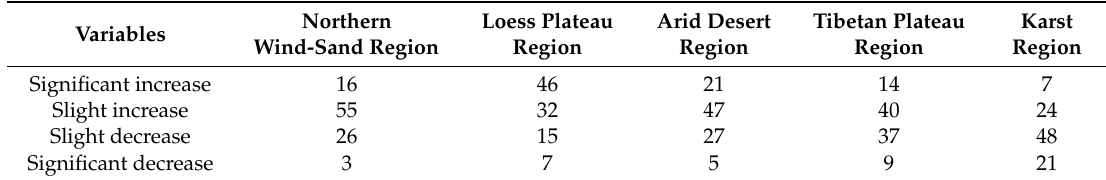
Figure 2. Spatial pattern of the actual NPP (NPP a ) change trends and significance level ( p < 0.05) in the Northern Wind-sand region ( a ), Loess Plateau region ( b ), Arid Desert region ( c ), Tibetan Plateau region ( d ), and Karst region ( e ) from 2000 to 2015. The blank area in the figure is an area of no vegetation, such as a desert, urban area, etc. Table 2. Spatial change statistics of the NPP a in the five ecologically vulnerable regions from 2000 to 2015